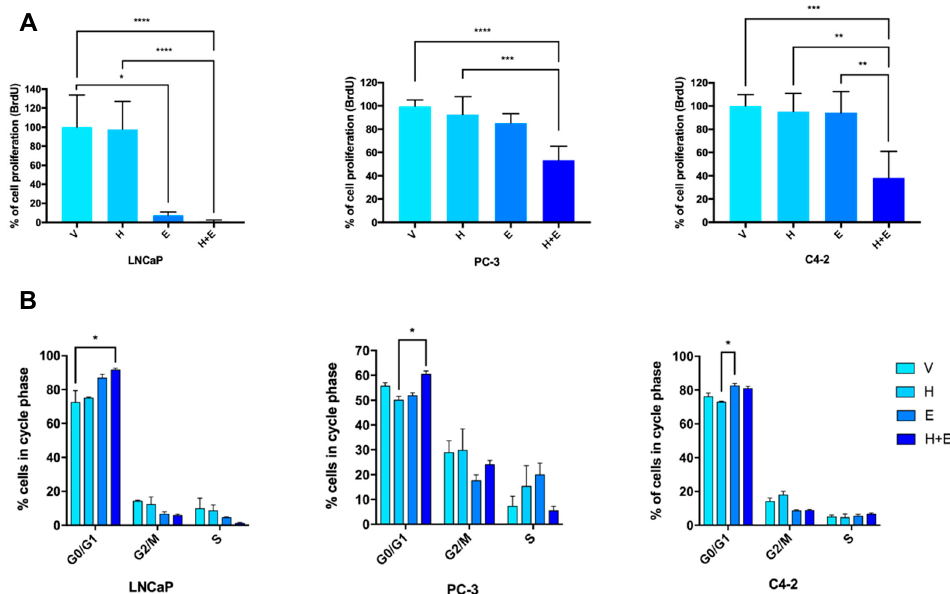
Figure 7. The combination of hydralazine and enzalutamide decreased cell proliferation in PCa (prostate cancer) cells. Percentage of cell proliferation (evaluated by BrdU assay). Values were normalized to the vehicle condition ( A ). Corresponding cell cycle analysis of PCa cells ( B ). (V—vehicle, H—hydralazine, E—enzalutamide, H+E—combination of hydralazine and enzalutamide).